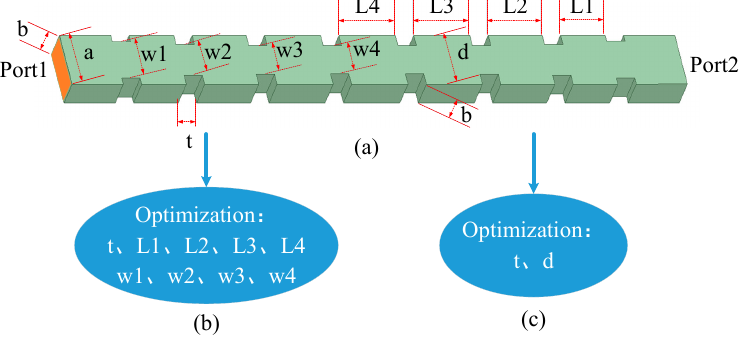
Figure 2. The 340 GHz terahertz filter structure and error correction methods: ( a ) 340 GHz 7-order inductive diaphragm waveguide filter structure; ( b ) GOC method; ( c ) DOC method.